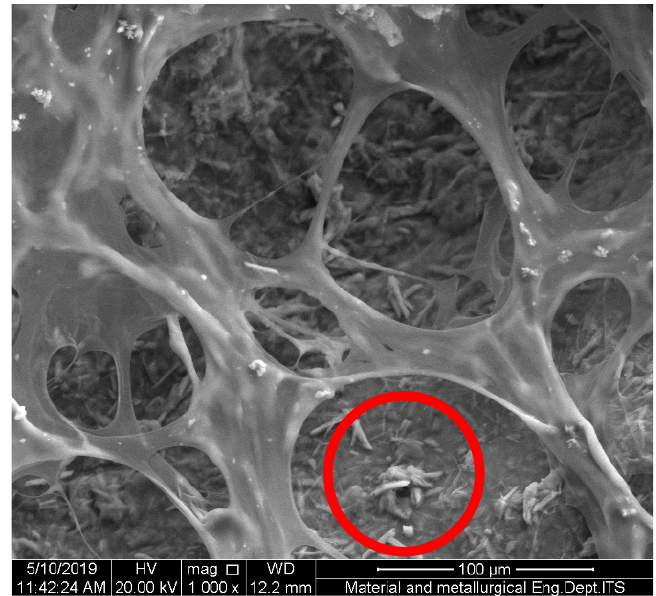
Figure 3. SEM images of hydrogel Alginate/PVA/r-GO with 1.6 wt.% r-GO with magnification 1000×. The microscale graphite is shown by the red circle.